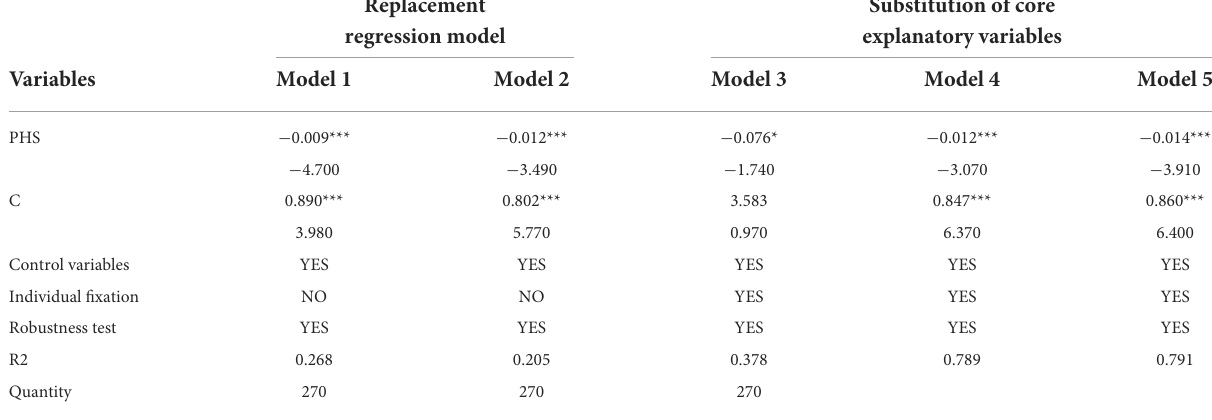
TABLE 10 Robustness